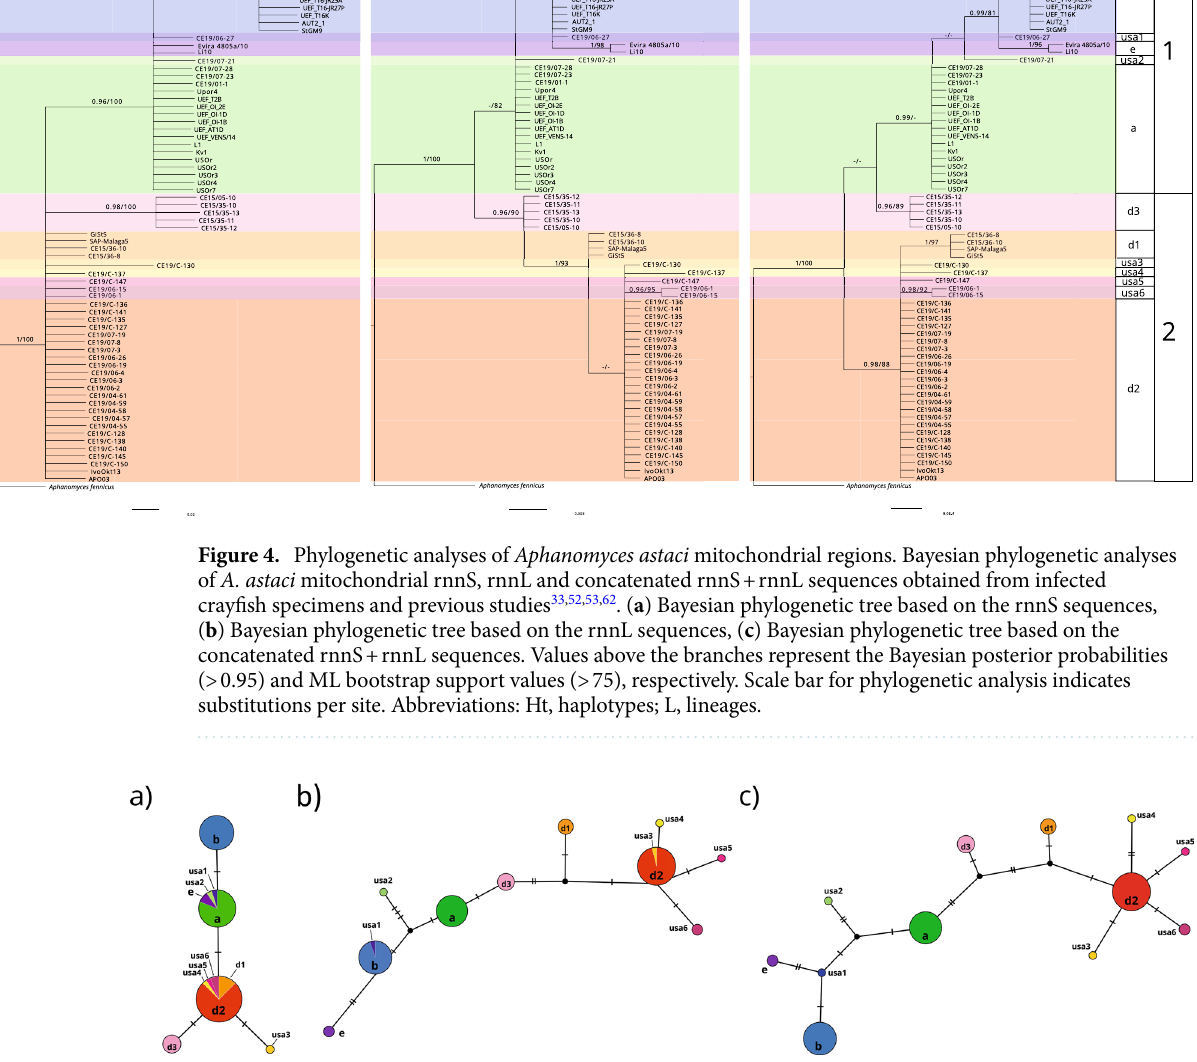
Figure 5. Haplotype network based on rnnS, rnnL and concatenated rnnS + rnnL mitochondrial DNA sequences, generated by statistical parsimony. The area of the circles is proportional to the number of sequences. ( a ) Haplotype network based on rnnS mtDNA sequences, ( b ) Haplotype network based on rnnL mtDNA sequences, ( c) Haplotype network based on concatenated rnnS + rnnL mtDNA sequences. Mutation steps between haplotypes are shown as hatch